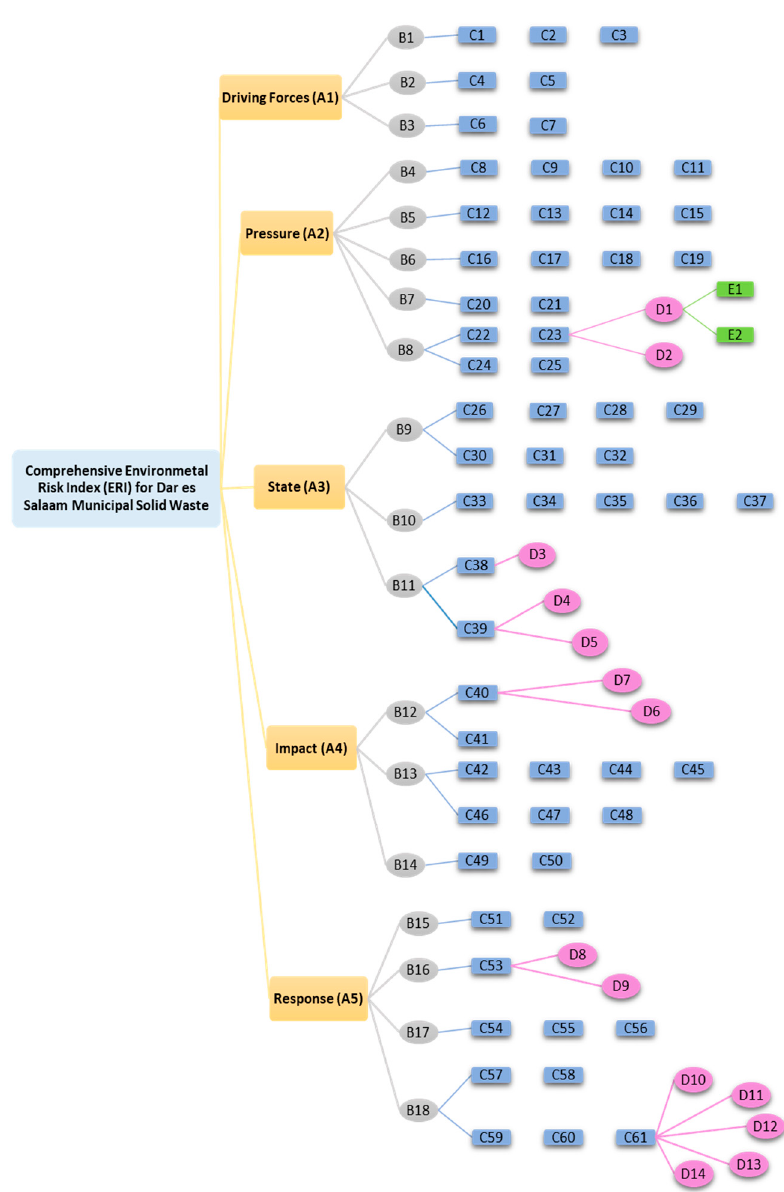
Figure 1. Hierarchical Organization of ERI system for Dar es Salaam MSW in DPSIR Model.